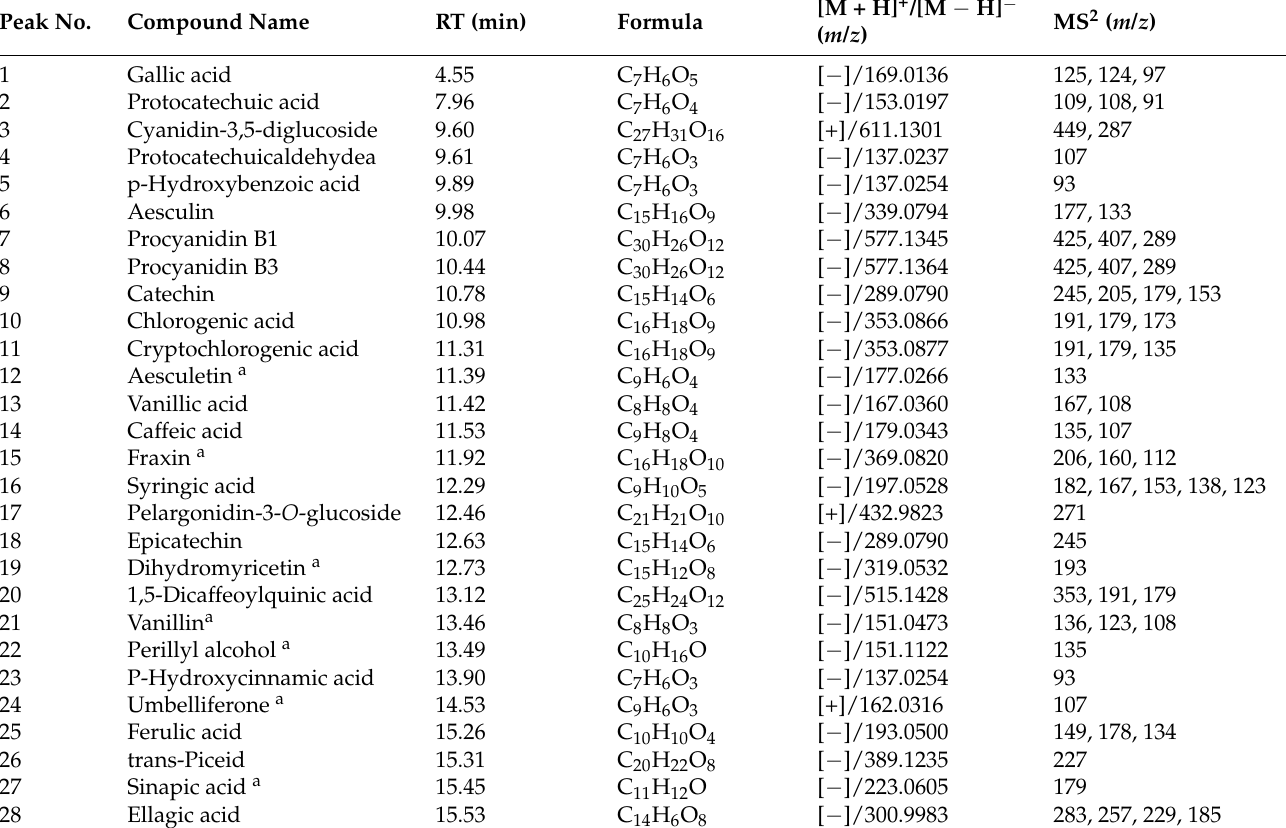
Table 2. Identification of phenolic compounds in the different mulberry